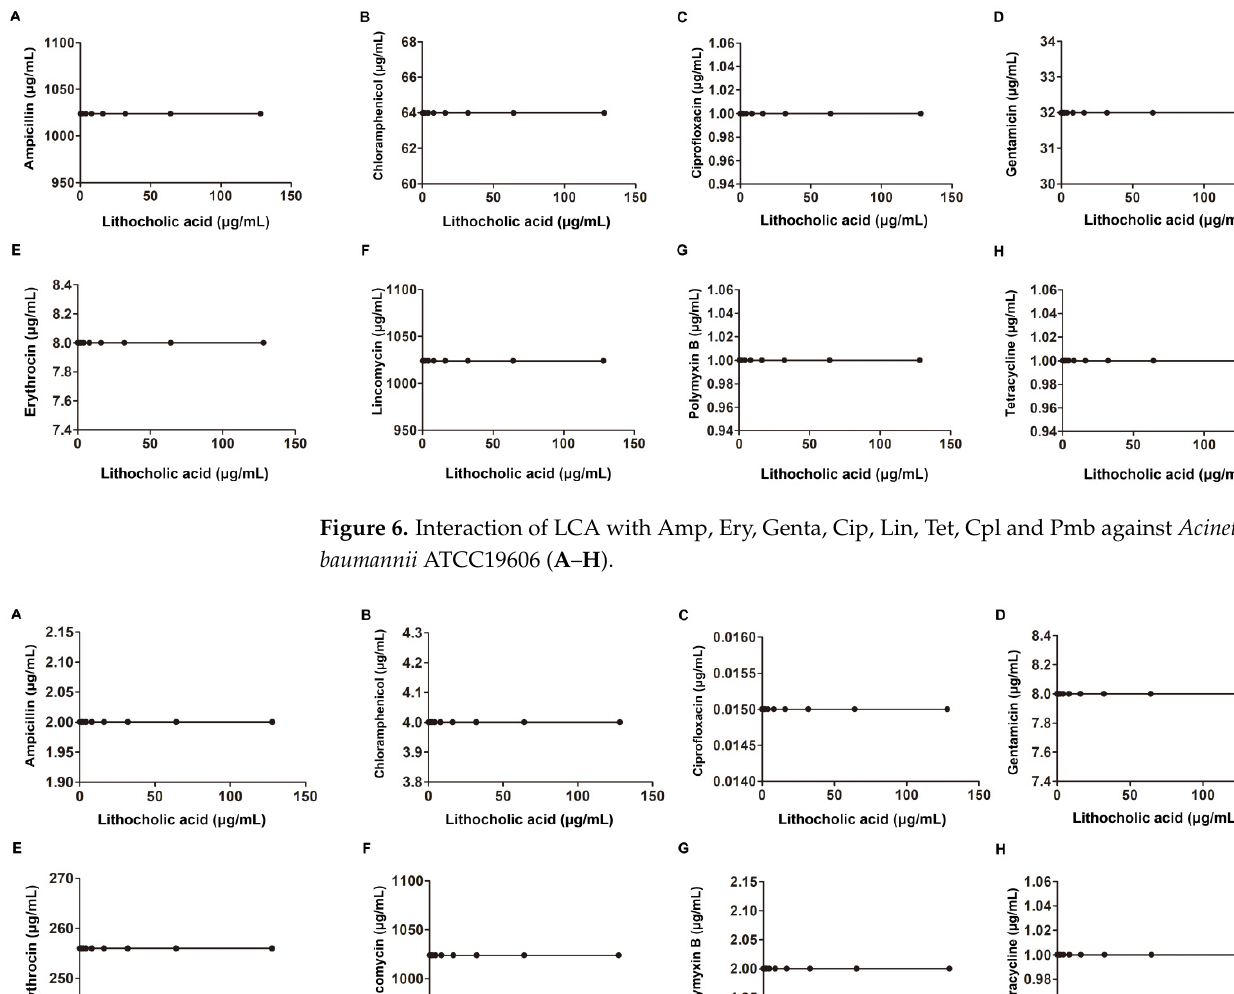
Figure 5. Interaction of LCA with Amp, Ery, Genta, Cip, Lin, Tet, Cpl and Pmb against E. coli ATCC25922 ( A – H ).